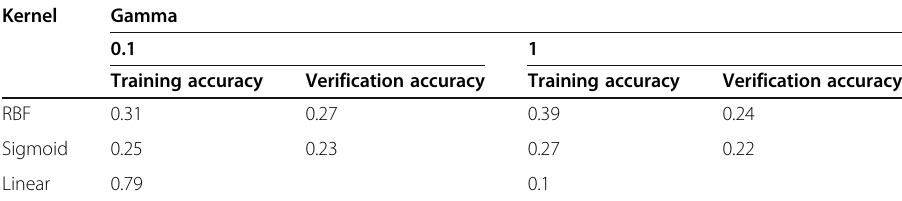
Table 5 Results using the first